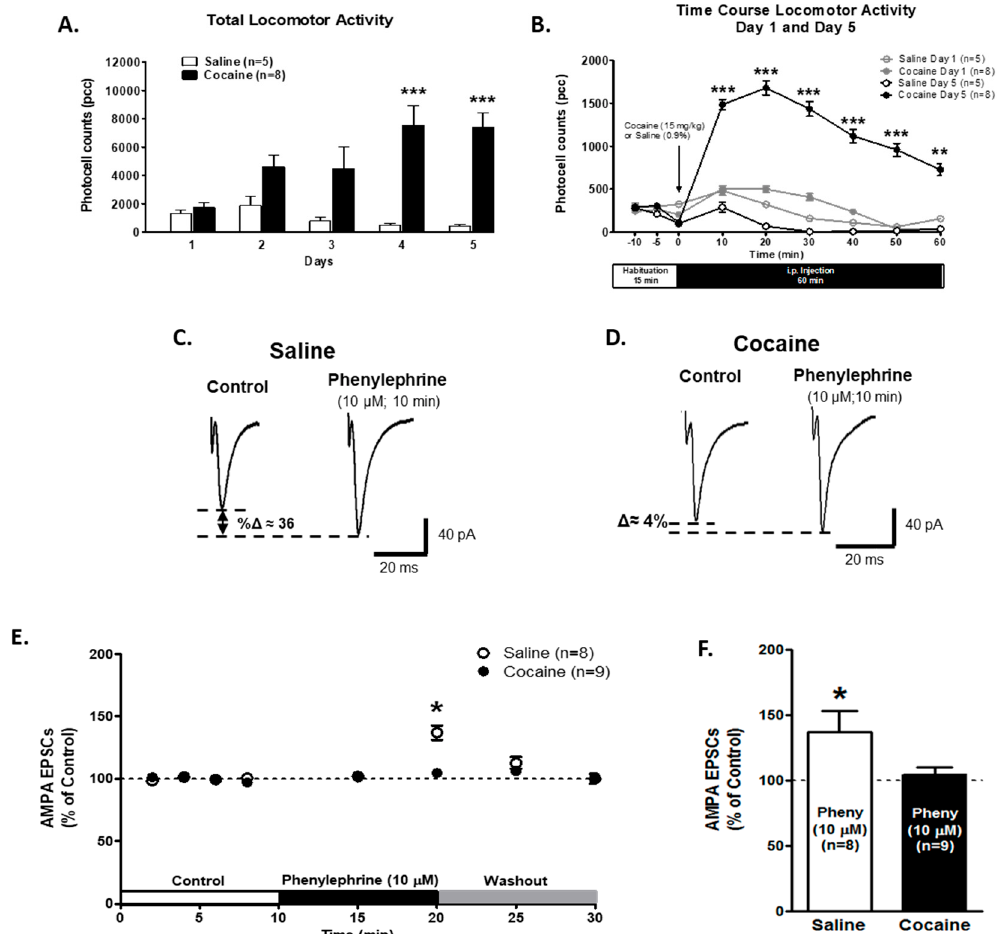
Figure 2. α 1-ARs-mediated effect on AMPA EPSCs is absent in the VTA DA neurons of cocaine sensitized animals. ( A ) The bar graph shows the total locomotor activity recorded from saline- (0.9%, white bars; n = 5) and cocaine- (15 mg/kg i.p., black bars; n = 8) treated animals. Cocaine-injected animals show a progressive increase in locomotor activity over 5 days. On days 4 and 5, the total activity was significantly increased when compared to day 1 in cocaine-treated animals (Two-way repeated measures ANOVA, Bonferroni post hoc test p < 0.001). ( B ) The time course of locomotor activity on days 1 (grey) and 5 (black) of cocaine- (15 mg/kg, i.p.) (filled) or saline- (unfilled) treated animals. Cocaine sensitization was manifested as an increase in locomotor activity during the first 10– 50 min after cocaine injection in comparison with day 1. The data (pcc/60 min; Mean ± SEM) were analyzed by Two-way repeated measures ANOVA, Bonferroni post hoc test ( p < 0.001). ( C , D ) Representative recordings from saline- and cocaine-treated animals, respectively, illustrating that phenylephrine superfusion (10 μ M, 10 min) induces a significant increment in AMPA EPSCs amplitude only in VTA DA neurons from saline-treated animals. ( E ) A time course summary of the effects of phenylephrine bath application on AMPA EPSCs amplitude recorded from VTA DA neurons from saline-treated animals ( n = 8/5) and VTA DA neurons from cocaine-treated animals ( n = 9/8) at 8 min after control recording (2 min intervals), 5 and 10 min phenylephrine (10 μ M), and 5 and 10 min washout. A 10 min phenylephrine application increased the AMPA EPSCs amplitude only in neurons from saline-treated animals compared to control recordings (One-way ANOVA, Newman- Keuls post-hoc, p < 0.05). A washout of phenylephrine’s response was observed. ( F ). A bar graph showing that, in neurons from saline-treated animals ( n = 8), phenylephrine application resulted in an ~36% increase in AMPA EPSCs amplitude compared to control recordings (One-way ANOVA, Newman-Keuls post-hoc, p < 0.05). No significant differences were observed on VTA DA neurons in cocaine-treated animals ( n = 9) after 10 min of phenylephrine application (104.6 ± 5.3%). Two-way repeated measures ANOVA showed in factor time, at 10 min of phenylephrine superfusion (F7,105 =